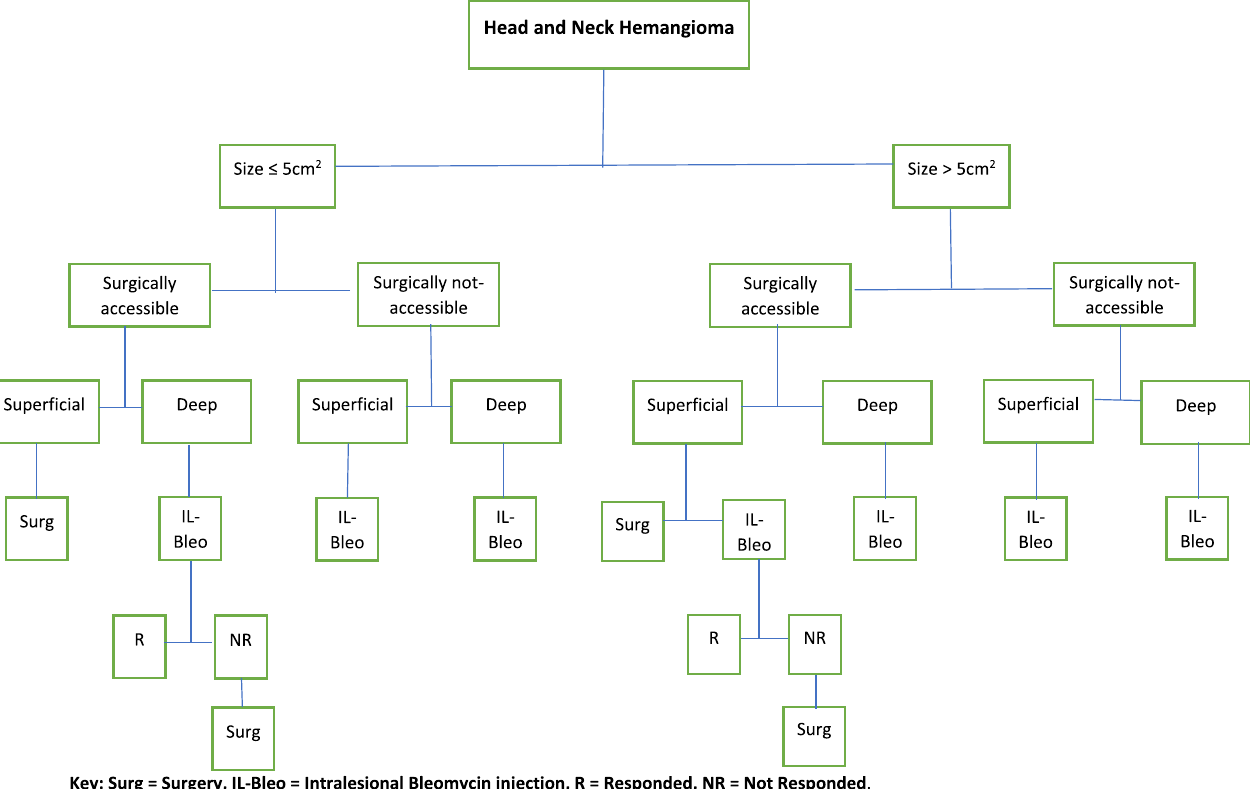
Fig. 1. The algorithm of treatment protocol used in management of head and neck